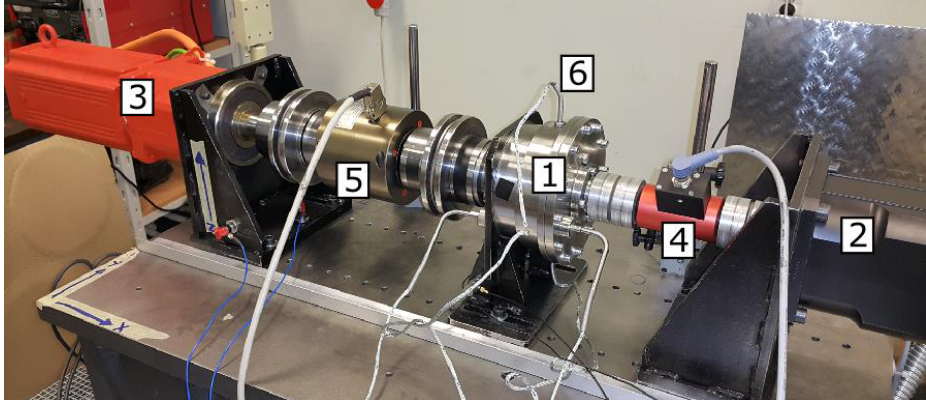
Figure 2. Test bench setup: 1 — tested cycloidal gear, 2 — driving electric motor, 3 — braking electric engine, 4 — torque and velocity meter for input, 5 — torque and velocity meter for output.